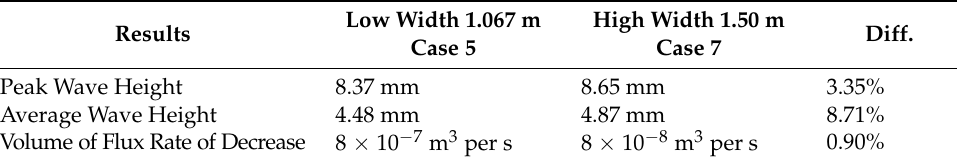
Figure 21. Low mold width (Case 5) vs. high mold width (Case 7) flux volume comparison. Table 5. Comparison of cases with a high and low mold width, namely cases 5 and 7.